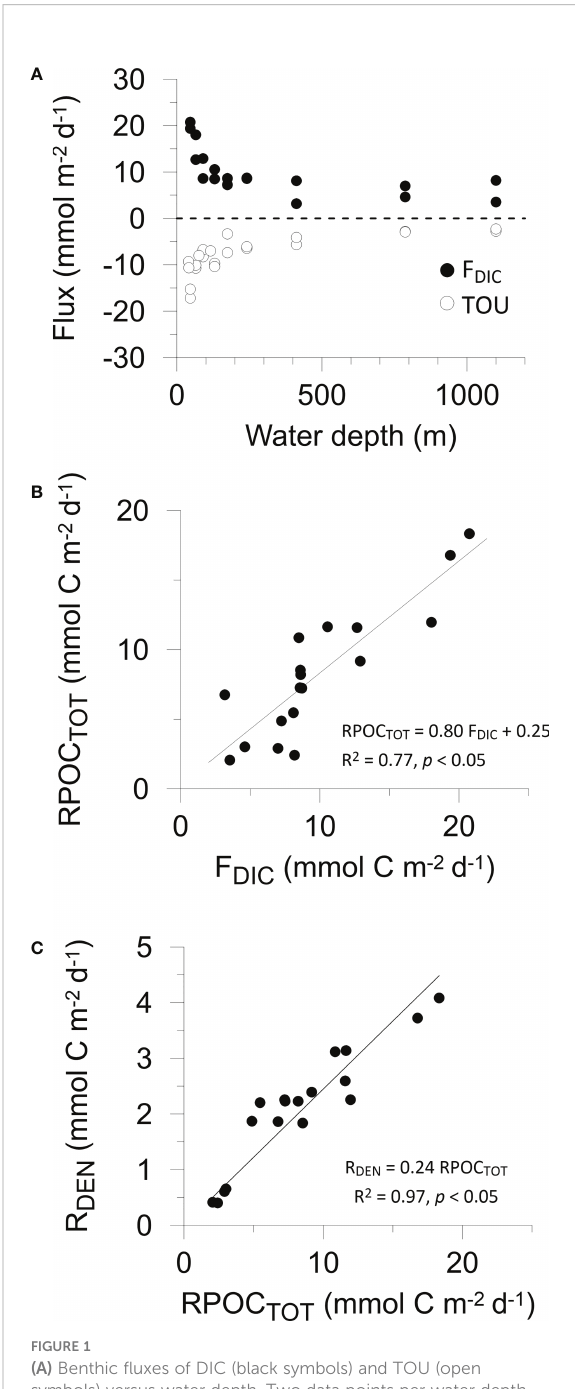
FIGURE 1 (A) Benthic fl uxes of DIC (black symbols) and TOU (open symbols) versus water depth. Two data points per water depth correspond to the two benthic chambers in each BIGO lander. Cross plots of (B) organic carbon degradation versus measured DIC fl ux, and (C) denitri fi cation versus organic carbon degradation, as determined by the mass balance. Denitri fi cation rates (Table 2) have been converted to mmol C m -2 d -1 by dividing by r NO3 . The trendline in (C) has been forced through the origin so that R DEN = 0 if RPOC TOT = 0. For (B, C) , Pearson correlation coef fi cients and p values are